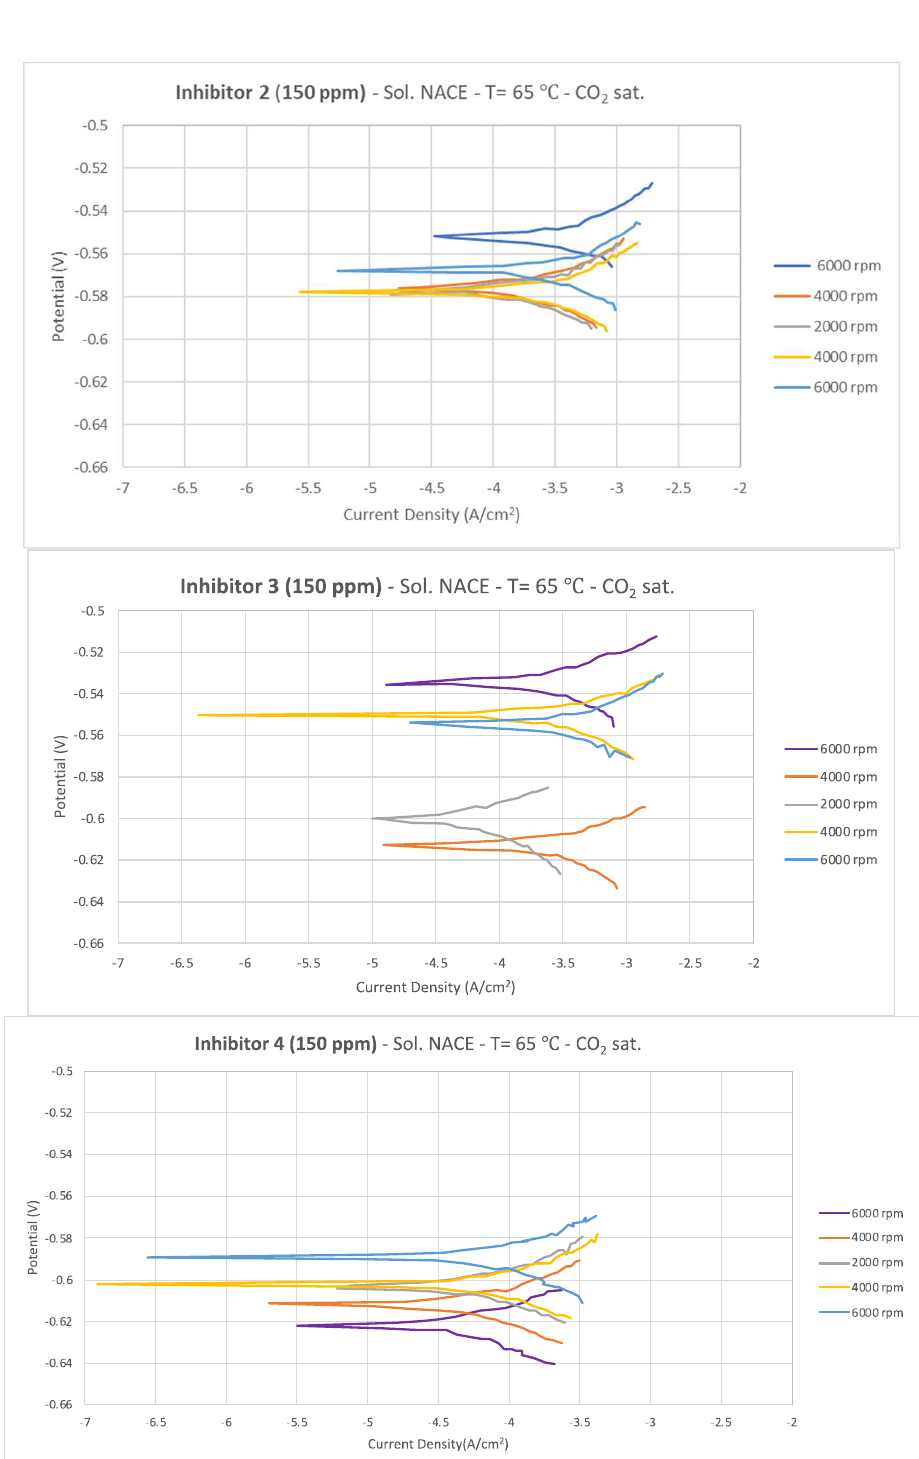
Figure 2. Curves obtained through polarization resistance to different rpm of the corrosion inhibitors. Out of the four inhibitors that were tested at a 150 ppm concentration, Inhibitor 1 was the one that had an efficiency equal to or greater than 90%. The rest of the corrosion inhibitors did not reach a 90% efficiency in any of the tests with the rotating cylinder. The oil company considers that an inhibitor passes the test if its corrosion efficiency is equal to or greater than